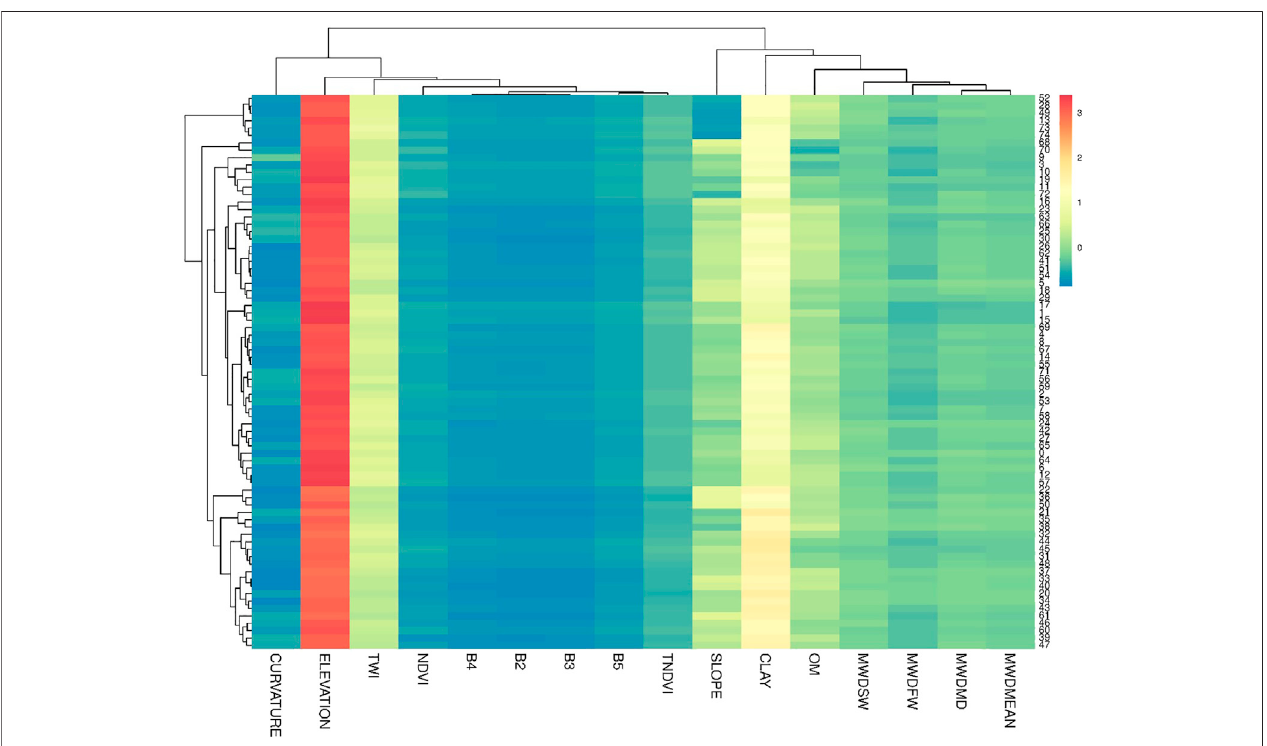
FIGURE 4 | Two-dimensional clustered heatmap based on the correlation matrix of studied variables. Weak correlations are displayed in low color intensity, while stronger ones are shown with high color intensity. Positive correlations were represented by red color, while negative ones were marked in turquoise.